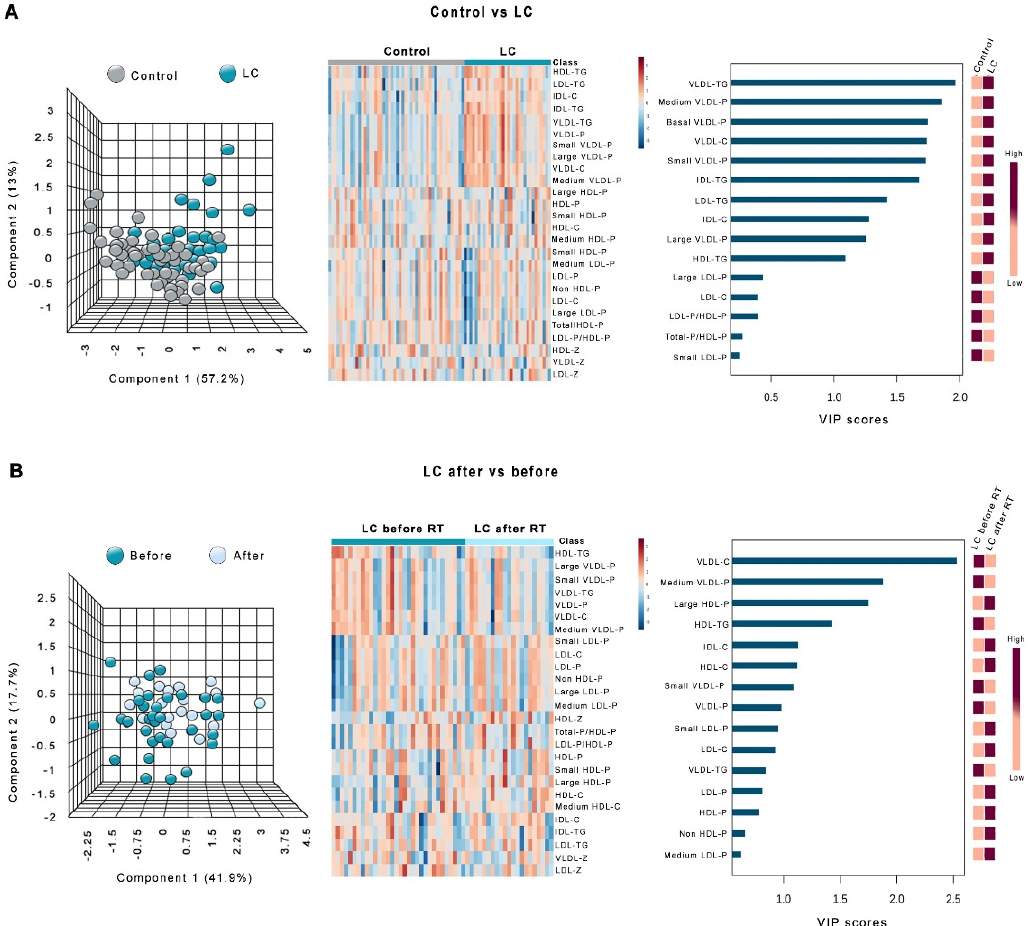
Figure 3. Principal component analysis (PCA) scores, heatmaps, and variable importance in projection (VIP) scores of the partial least squares discriminant analysis (PLSDA) in lung cancer (LC) patients vs. the control group ( A ) and in LC patients before and after radiotherapy ( B ). HDL: high-density lipoproteins; IDL: intermediate-density lipoproteins; LDL: low-density lipoproteins; VLDL: very-low-density lipoproteins. The suffix –P indicates number of particles, and the suffix –Z indicates the particle diameter.